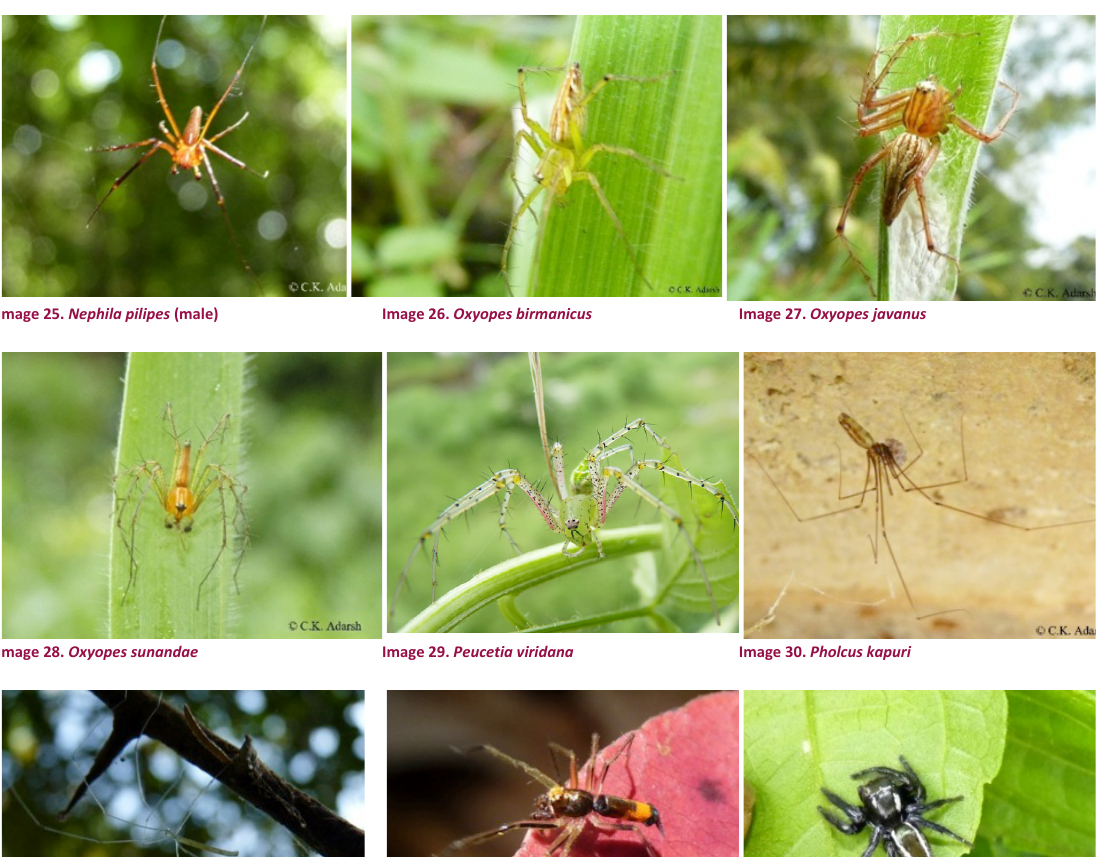
Image 31. Pholcus sp. Image 32. Asemonea tenuipes Image 33. Carrhotus viduus